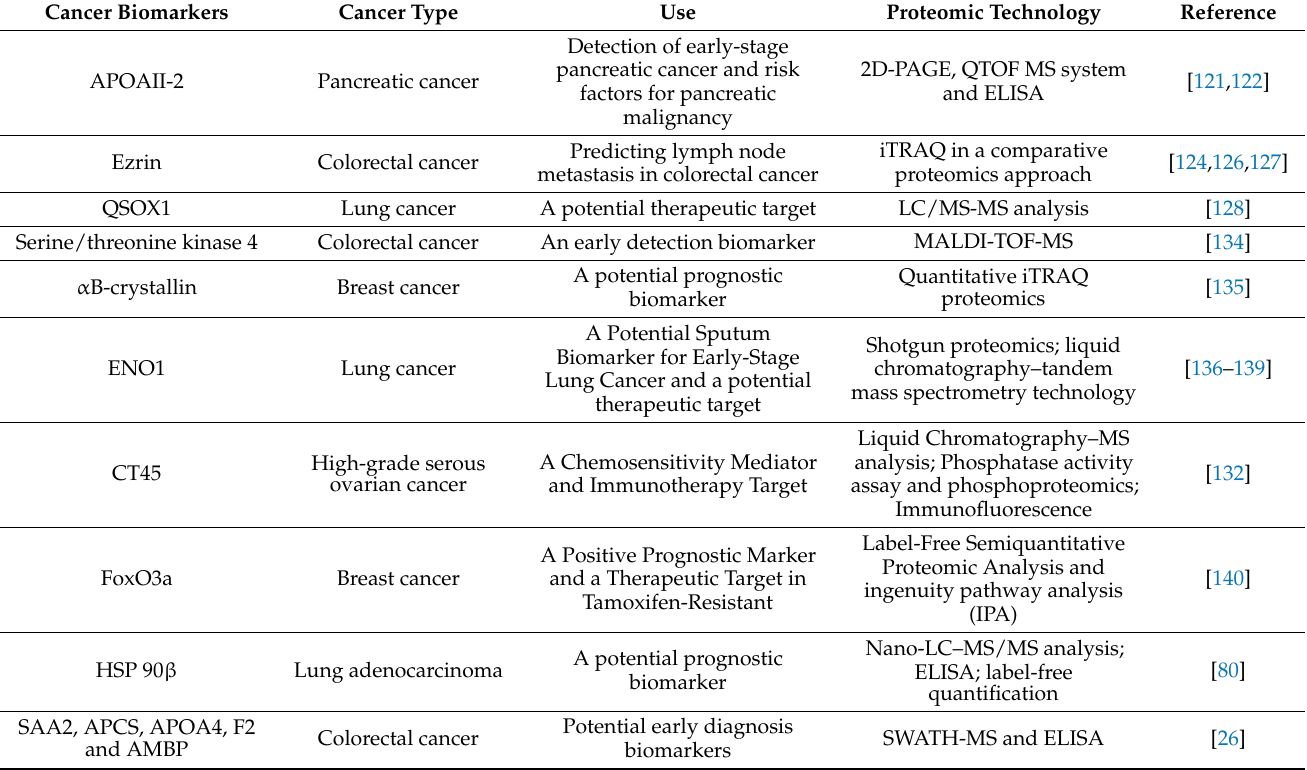
Table 2. Examples of cancer biomarkers: discovered by proteomics and their applications in precision medicine. Cancer